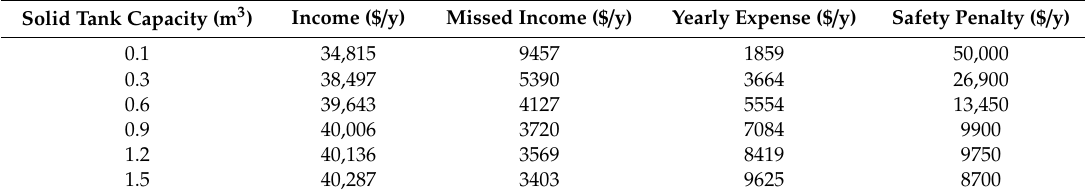
Table 7 resumes the values of the yearly profits, expenses and expected penalty for the possible solutions of the solid tank. Table 7. Profits and costs for several sizes of solid tank.